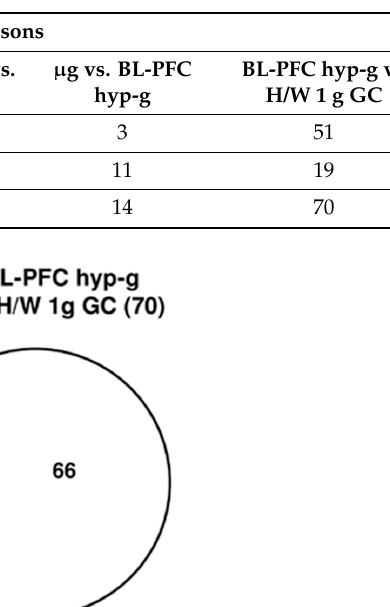
Table 2. Numbers of differentially expressed probe sets in response to altered gravitational conditions in Jurkat T cells during the 23rd DLR PFC. Direct primary comparisons between the sample groups are shown.